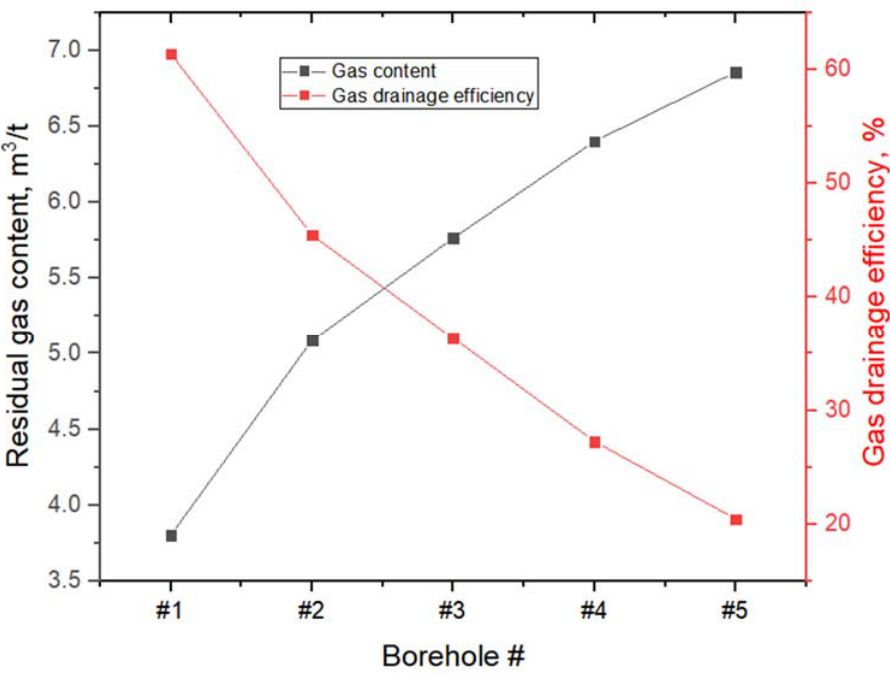
Figure 12. Residual gas content and gas drainage efficiency after 180 days of drainage.